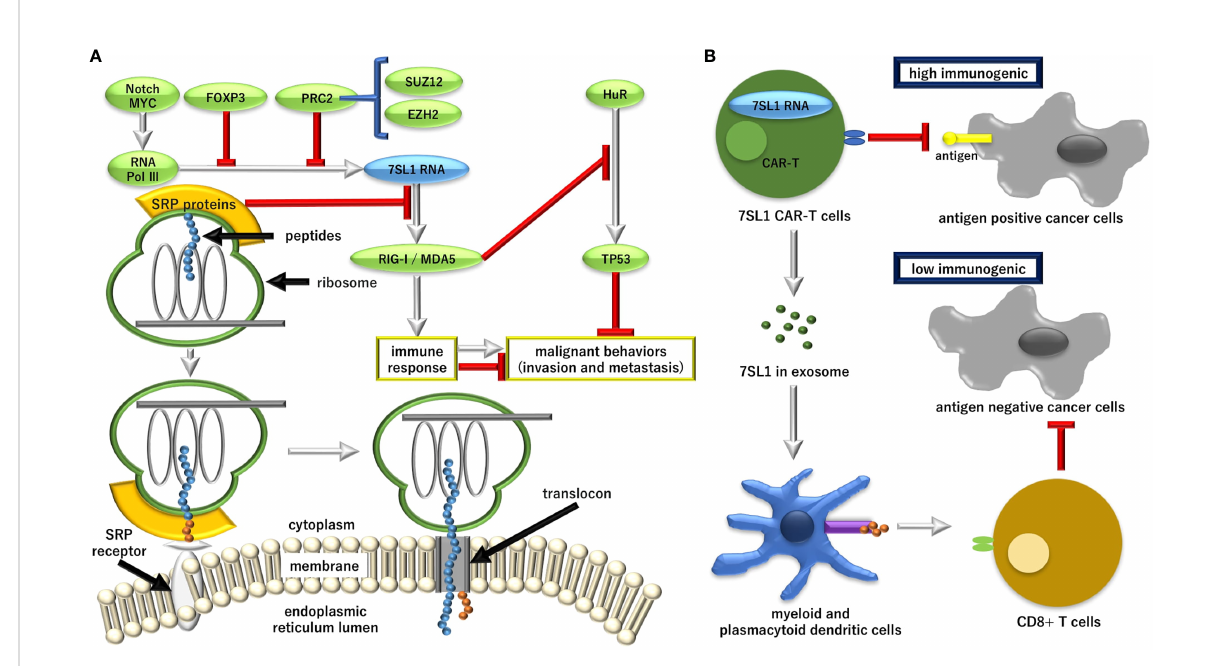
FIGURE 1 The role of endogenous immune stimulatory noncoding RNA 7SL1 in the pathway for the regulation of the aberrant protein production (RAPP) and its possible application in cancer therapy. (A) Transcriptional regulation of 7SL1 and the downstream mechanism for tumor suppressor tumor protein P53 (TP53). MYC, proto-oncogene, basic helix-loop-helix (BHLH) transcription factor (MYC); FOXP3, forkhead box P3; PRC2, polycomb repression complex 2; SUZ12, SUZ12 polycomb repressive complex 2 subunit; EZH2, enhancer of zeste 2 polycomb repressive complex 2 subunit; Pol II, RNA polymerase II; Pol III, RNA polymerase III; SRP, signal recognition particle; RIG-1, retinoic acid-inducible gene 1 protein; MDA5, melanoma differentiation-associated gene 5; HuR, embryonic lethal, abnormal vision, Drosophila (ELAV)-like 1, Hu antigen R. (B) Although the unshielded 7SL1-mediated stimulation of tumor tissues can result in disease progression, the exosomal delivery of 7SL1 or its combination with engineering chimeric antigen receptor (CAR)-T cells can stimulate an anti-tumor effect and lead to a favorable disease outcome. Ag,